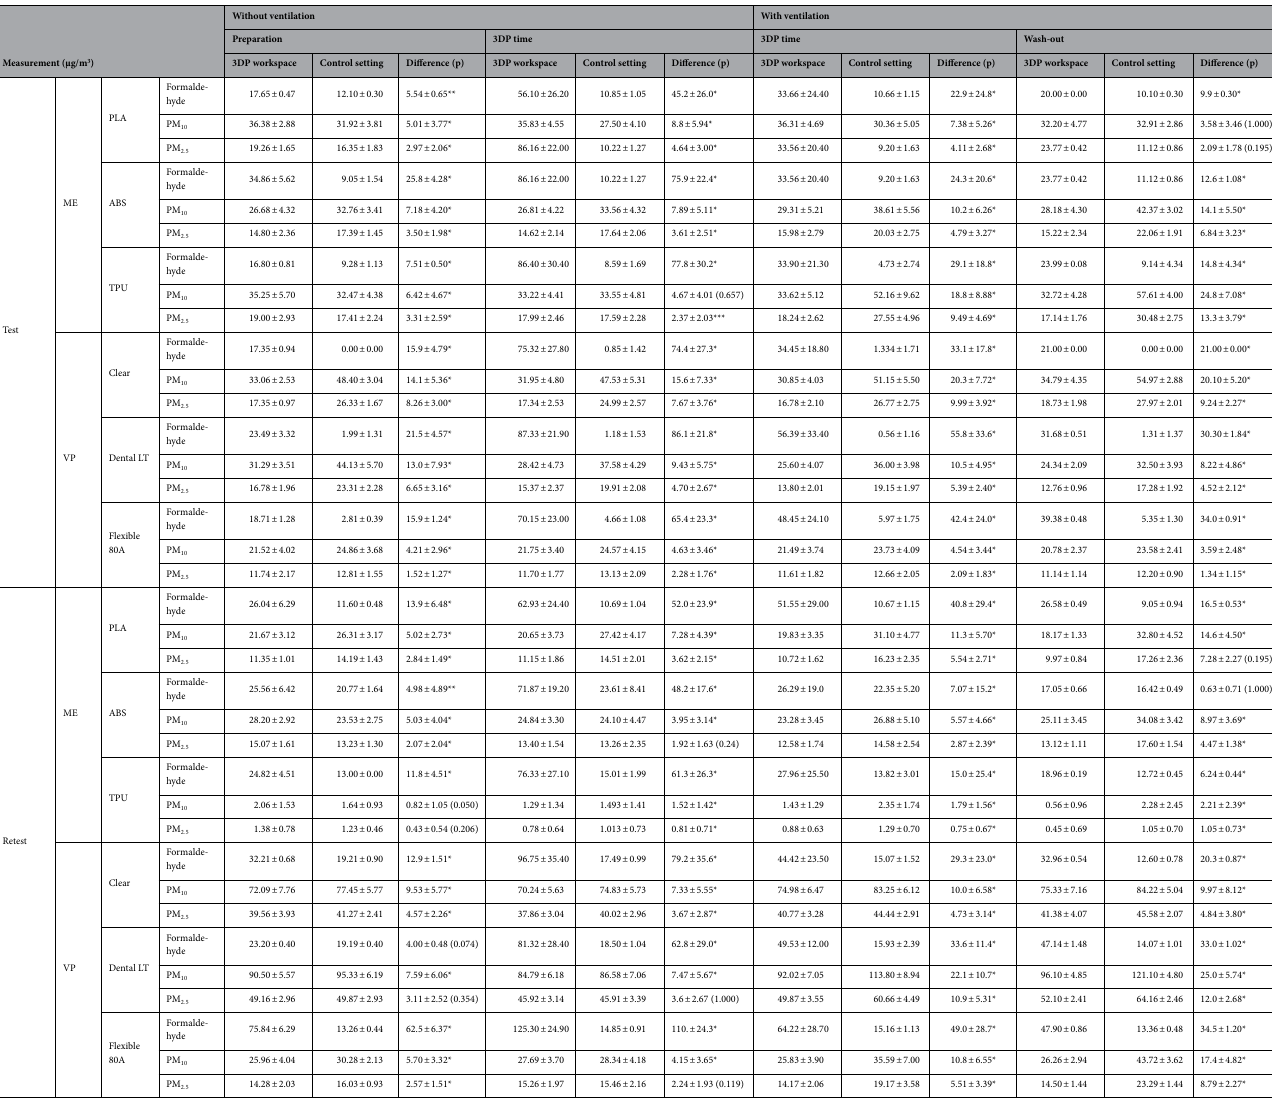
Table 1. The differences in formaldehyde, PM 10 , and PM 2.5 emissions between the 3DP workspaces and control settings for the PLA, ABS, and TPU of the ME and the Clear, Dental LT, and Flexible 80A resin of the VP in four stages with test–retest. *< 0.001, **< 0.05, ***< 0.01. 3DP 3D printing, ME materials extrusion, PLA polylactic acid,